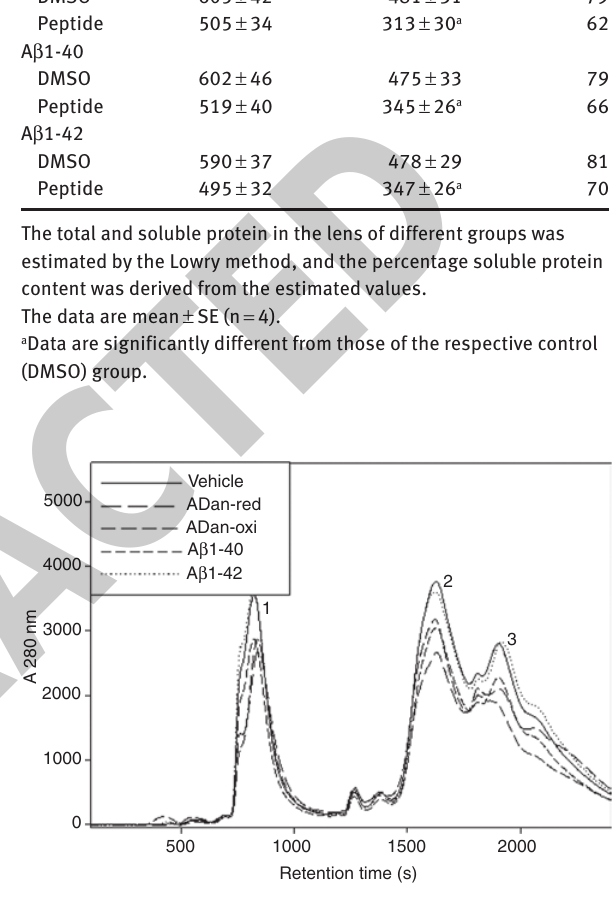
Figure 2: Crystallin profile of total soluble lens protein on gel filtration. Proteins from control (vehicle)-, ADan-red-, ADan-oxi-, A β 1-40-, and A β 1-42-injected eye lenses were loaded onto the column. The column was equilibrated, the proteins were eluted with the buffer, and absorbance was monitored at 280 nm. The traces are the average of four samples in each group. Peaks 1, 2 and 3 correspond to α -, β - and γ -crystallins,